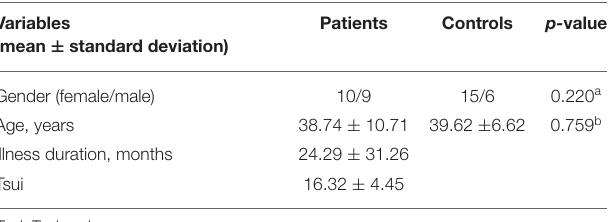
TABLE 1 | Demographics and clinical characteristics of the patients and the controls.